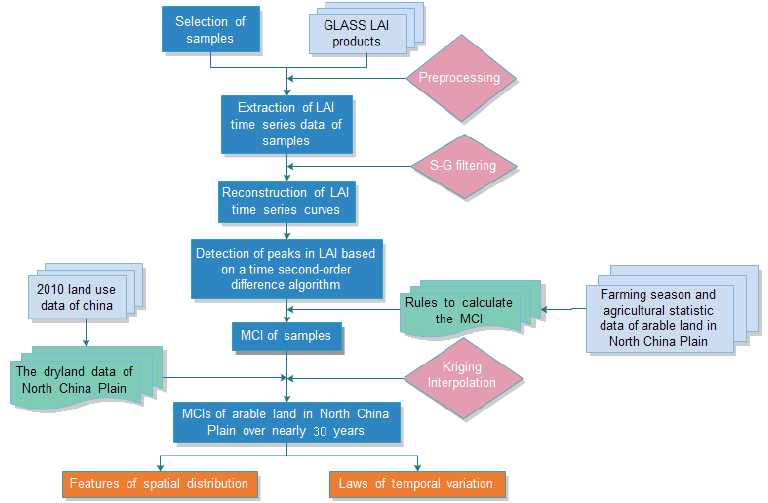
Figure 2. Schematic diagram of the extraction processes of multiple cropping indices (MCIs) of dry land. Note: LAI, leaf area index; GLASS, Global LAnd Surface Satellite.